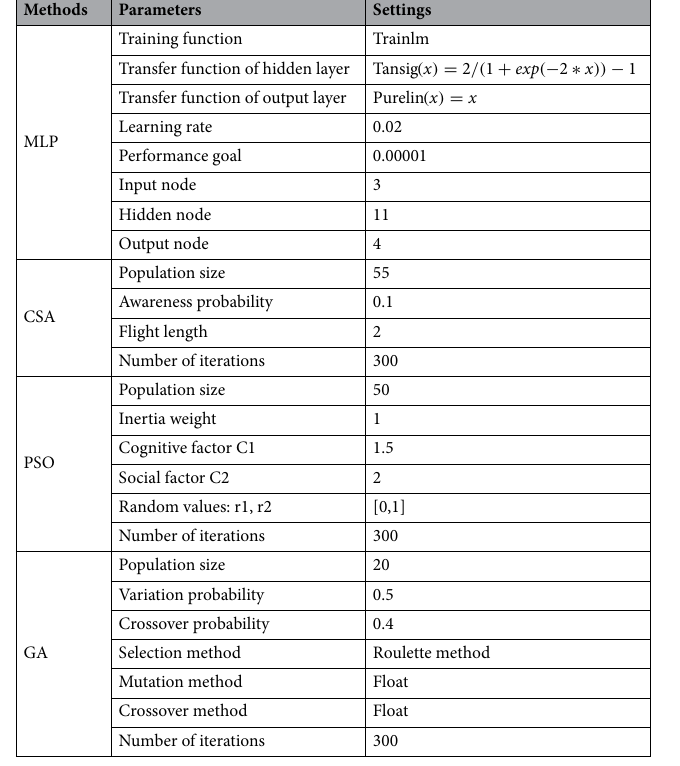
Table 2. Parameters and settings of the MLP training network, optimized models with CSA, PSO, and